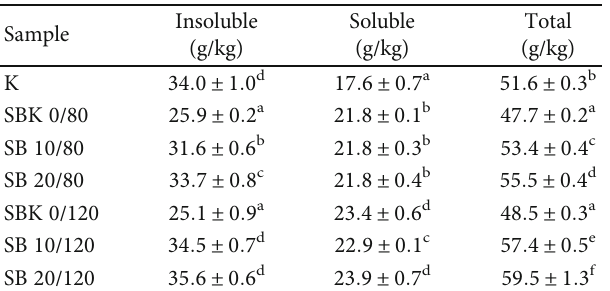
Table 2: Content of dietary fi ber in analyzed bread sample (in dry matter).